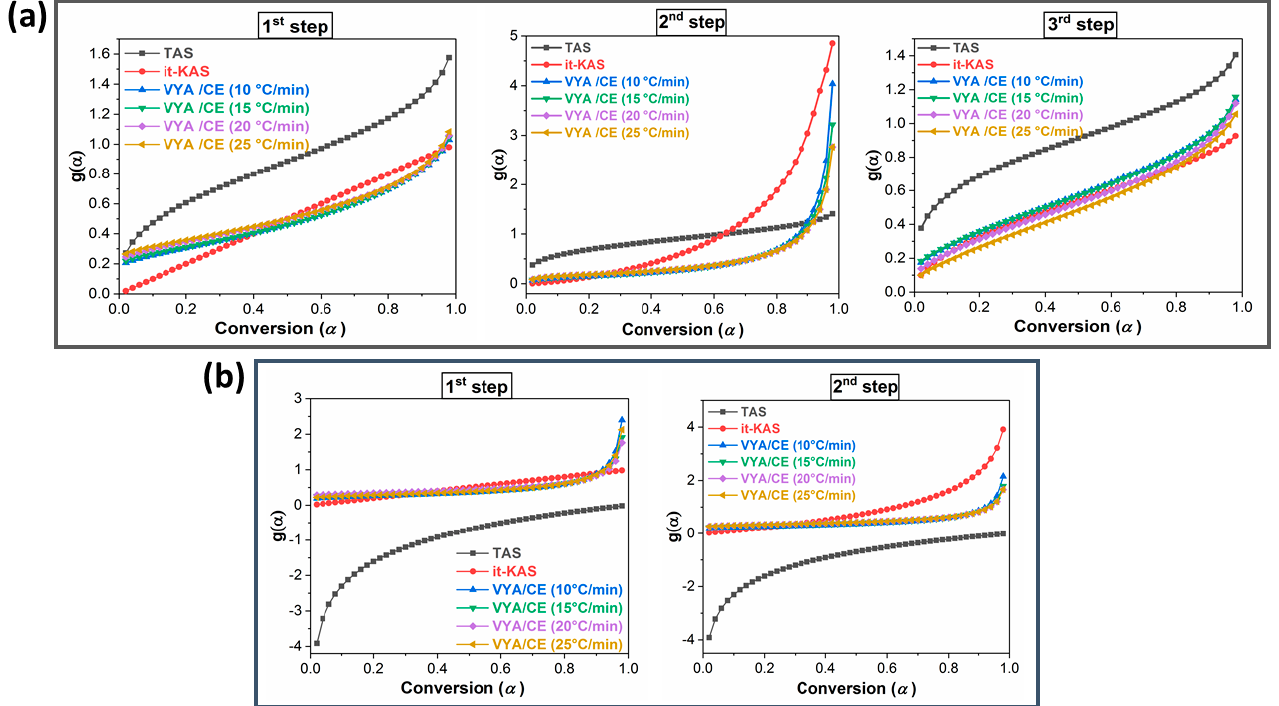
Figure 7. Variation in integral reaction model as a function of conversion for each decomposition step of ( a ) NC/HNTO/MgAlCuO; ( b ) NNC/HNTO/MgAlCuO.